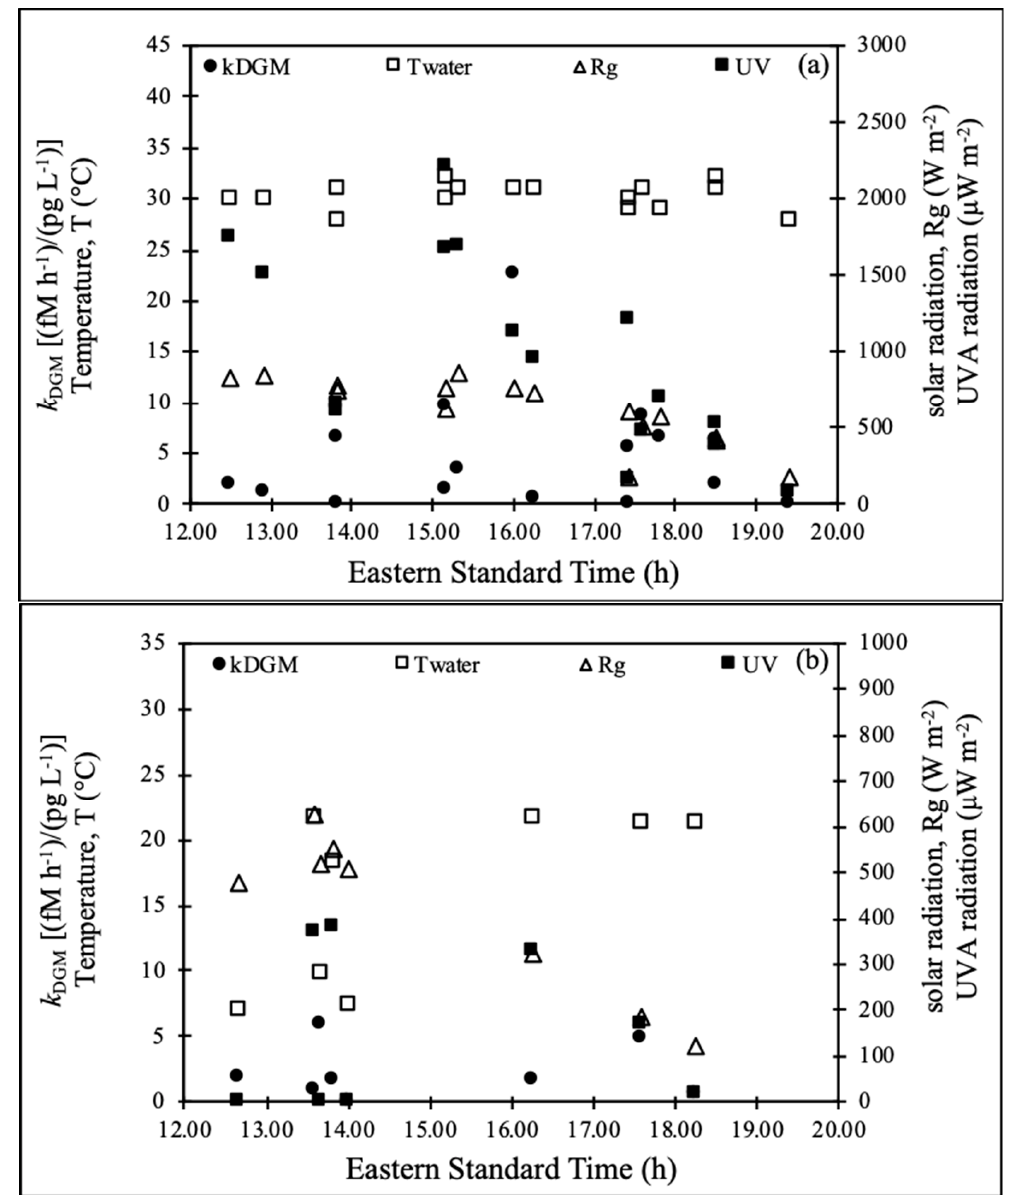
Figure 2. Examples of rate constants of aquatic Hg photoreduction calculated using a mass balance box model for ( a ) the warm season and ( b ) the cold season (model parameters in the model Equation (6) used for calculations: F (flux) and DGM = real field data, [Hg(II)] 0 = 150 pg L − 1 , d = 200 cm, d 1 = 10 cm).